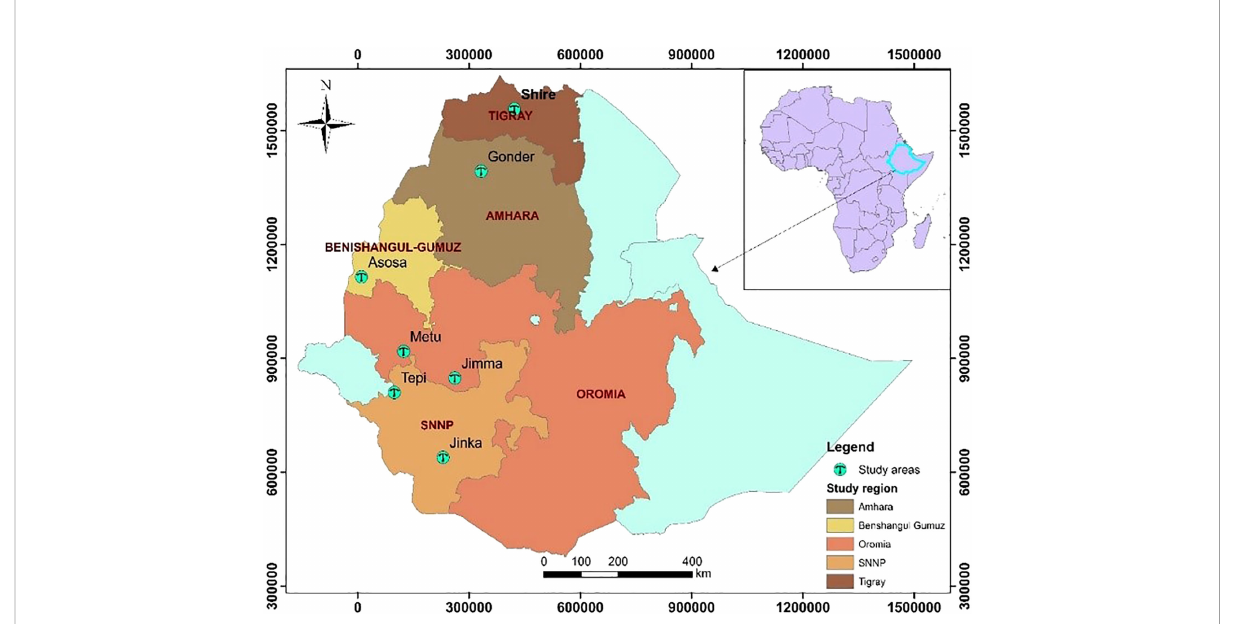
FIGURE 1 Geographical map (constructed using geographic information system (ArcGIS) showing testing environments: Jimma and Metu are situated Oromia regional state, Shire is located in Tigray regional state, Gondar situated Amhara regional state, Jinka and Tepi are located in southern nation, nationalities and peoples Regional State, Asosa (2018-2019) is situated Benishangul Gumez regional states.